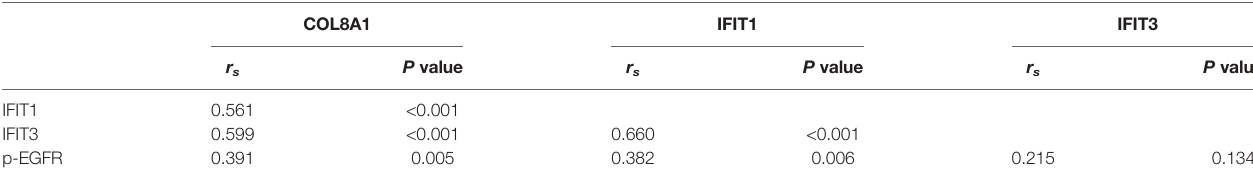
FIGURE 7 | Analysis of COL8A1, IFIT1, IFIT3, and p-EGFR in NSCLC tissues. The expression of COL8A1, IFIT1, IFIT3, and the phosphorylation of EGFR in NSCLC tissues detected by IHC staining. TABLE 3 | Spearman correlation analysis of expression among COL8A1, IFIT1, IFIT3 and p-EGFR in 50 NSCLC tissues by